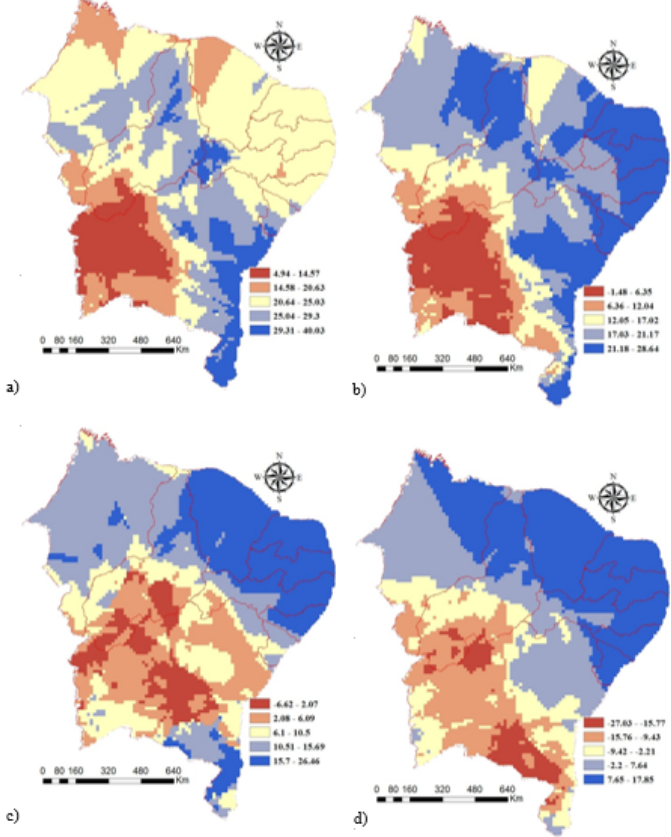
Figure 4. Comparison in percentage between the IDF’s gathered during this study and Pfafstetter (1957) for (a) 1h, (b) 4h, (c) 12h and (d) 24h duration. Positive values indicate highest rainfall in the newer rainfall